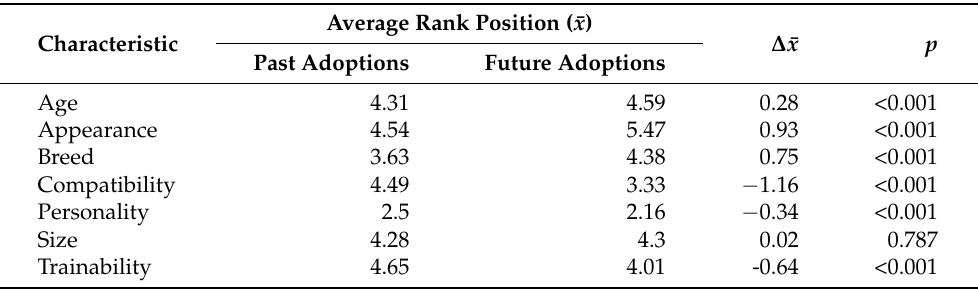
Table 1. Average characteristic rank positions for past and future adoptions. A lower rank position indicates a higher priority